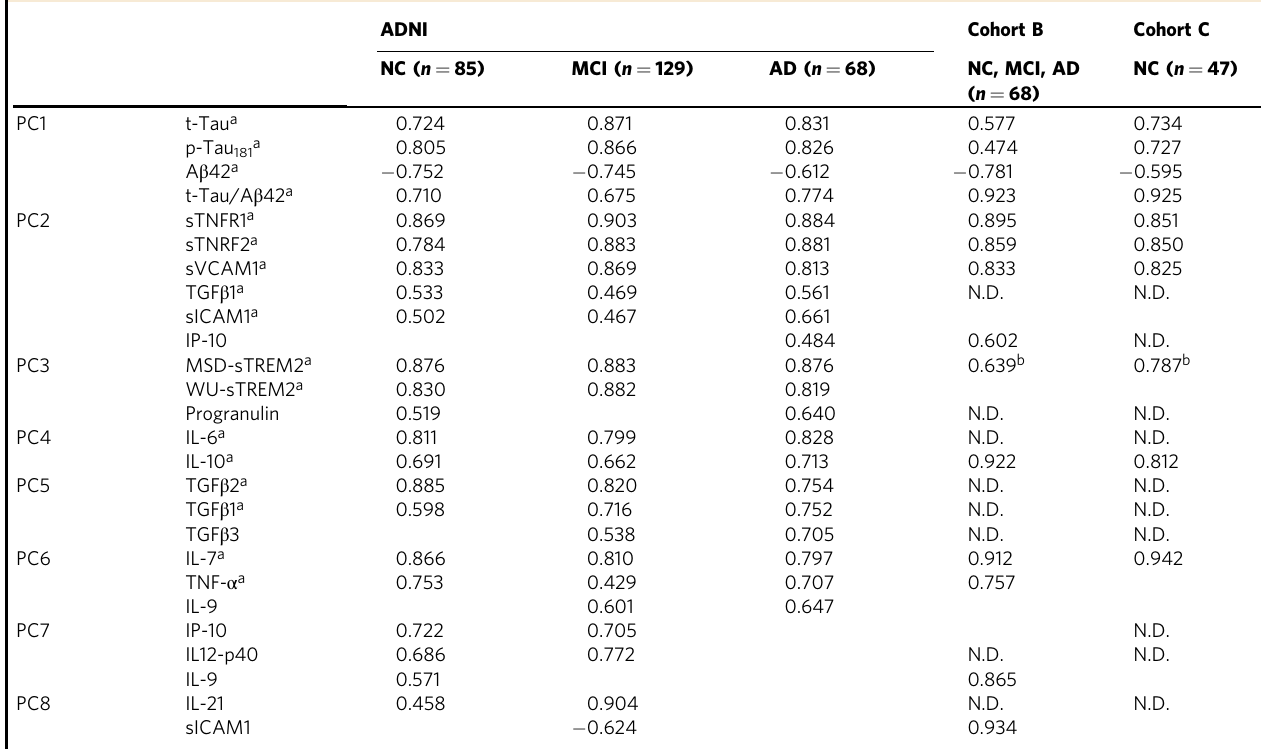
Table 2 PCA of CSF AD and in fl ammatory proteins in ADNI and two replication cohorts B and C, with loading values of proteins consistently associated with two or more PCs shown.